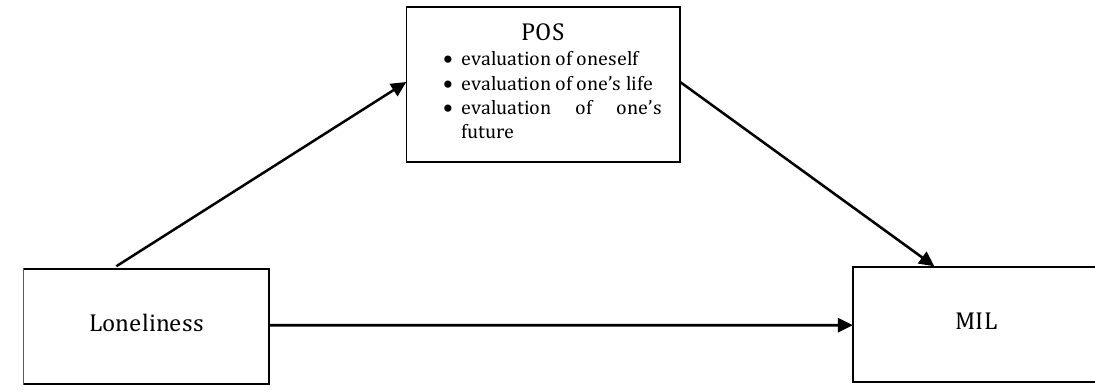
Figure 1. Proposed simple mediation model.